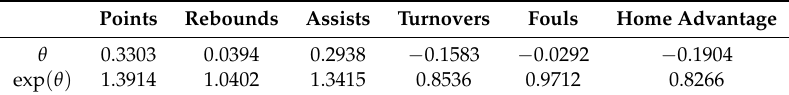
Table 2. Parameter estimation result.